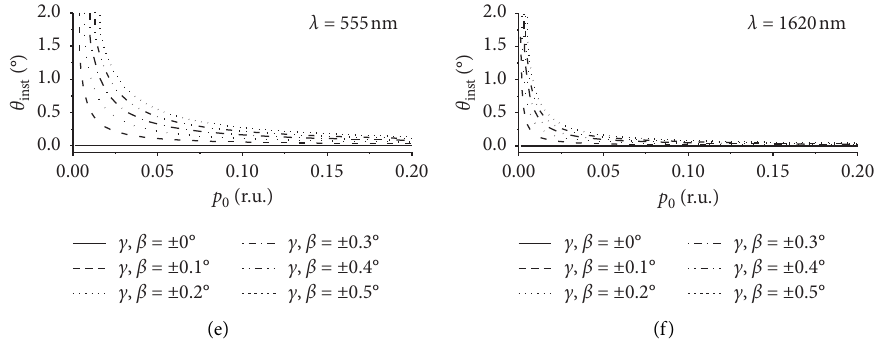
Figure 9: Dependence of the boundary value of the azimuth θ inst of the instrumental polarization of the TSM on the mirror M 2 tilt around axes 1 and 2 (as shown in Figure 5) at degrees of linear polarization p 0 < 0.2.